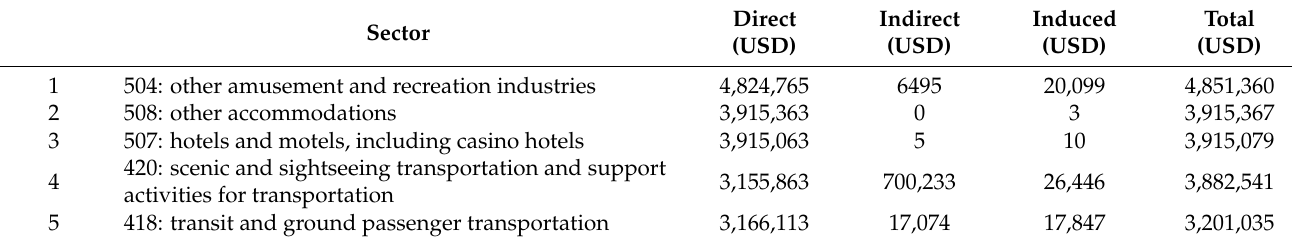
Table A26. Top Five Affected Sectors by